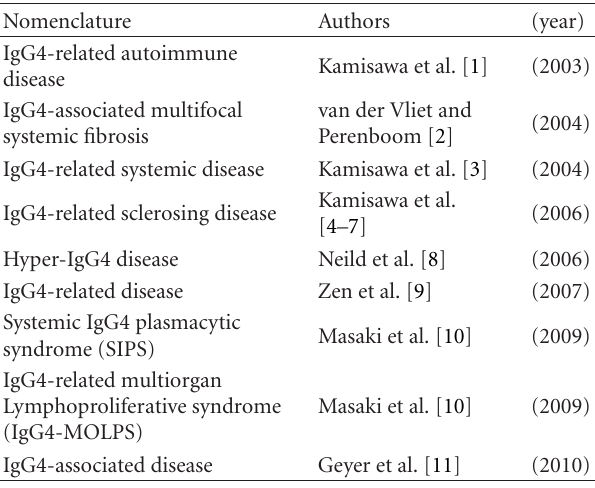
Table 1: Nomenclatures of IgG4-related